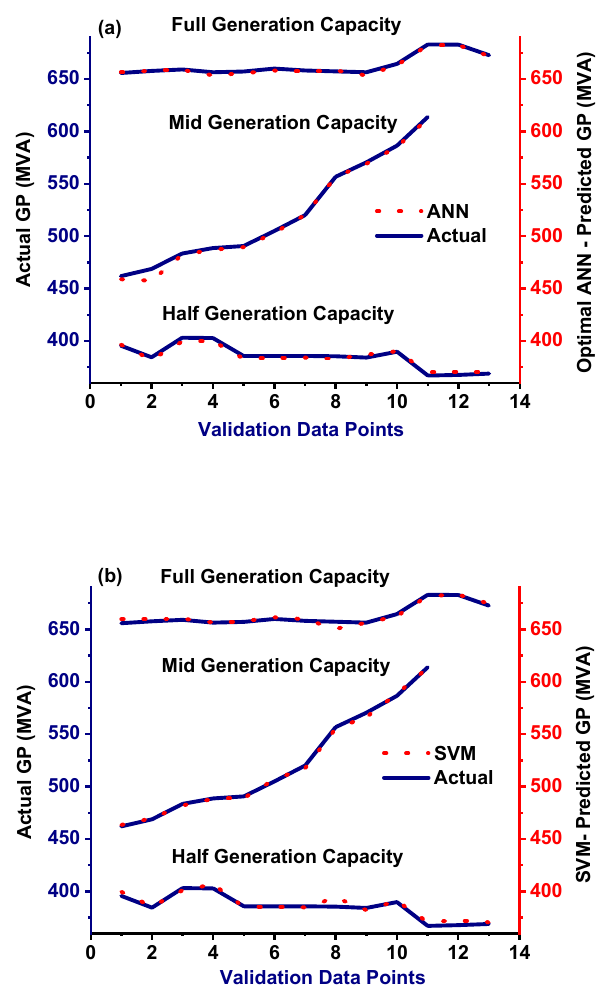
Figure 6. Graphs of external validation data: ( a ) optimal ANN; ( b ) support vector machine (SVM).